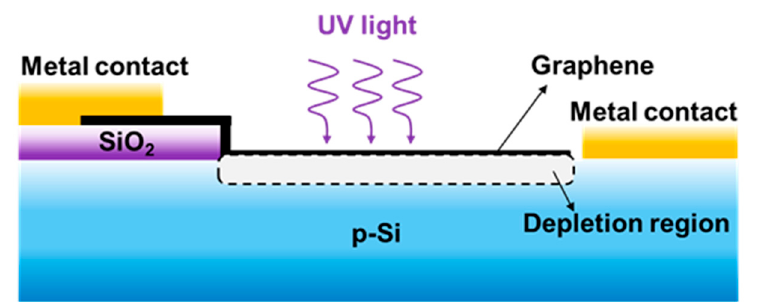
Figure 5. Schematic cross-section of the camphor-based CVD bilayer graphene/p-Si Schottky PD structure.